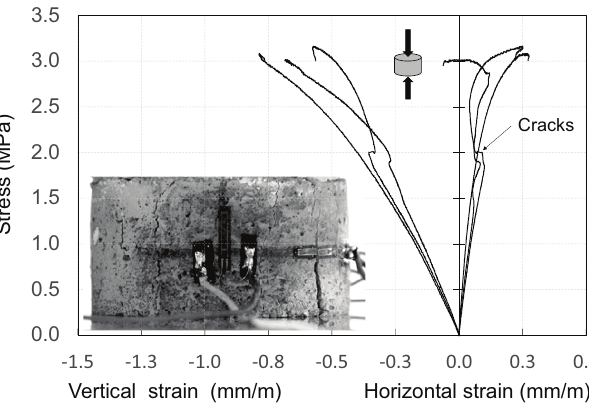
Figure 16 Force/time protocol for mortar test